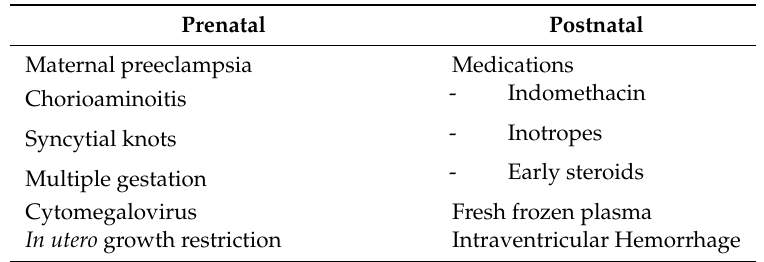
Table 1. Risk factors associated with increased incidence of SIP in preterm neonates. Prenatal